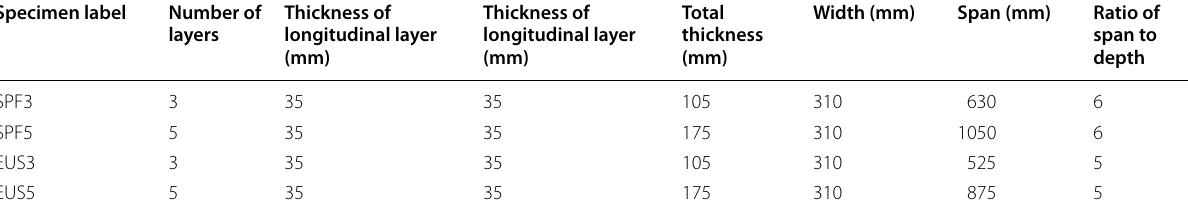
Table 2 Dimensions of test specimens Specimen label